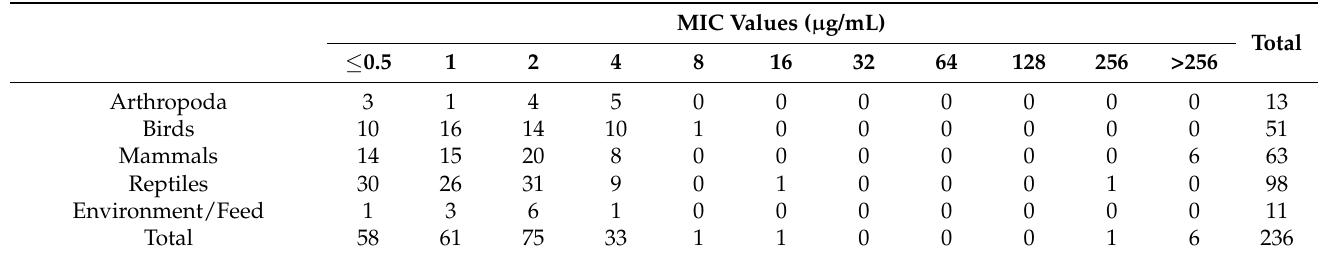
Table 3. Distribution of the tested Salmonella strains in relation to minimum inhibitory concentration (MIC) values and animal